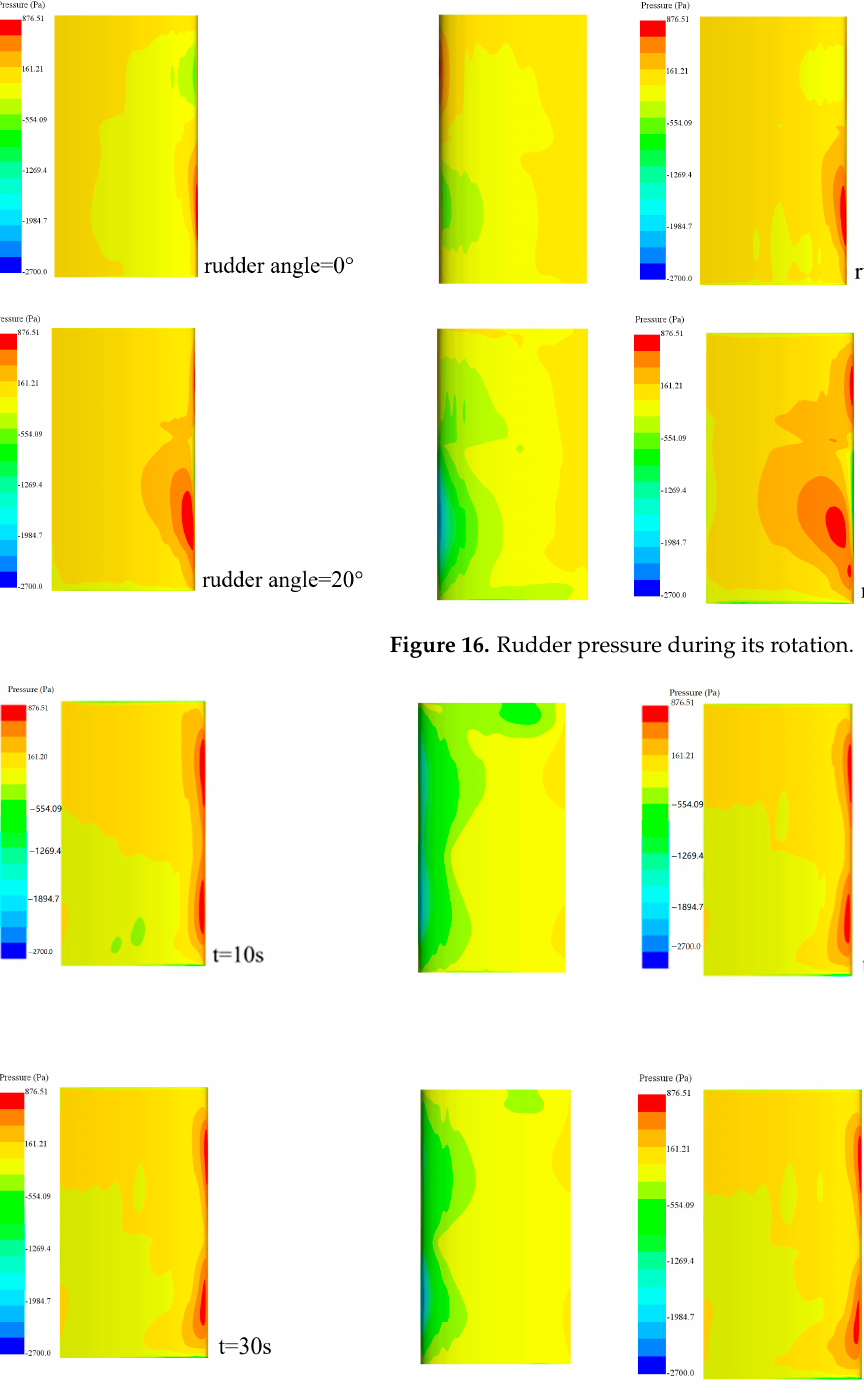
Figure 18. +35° drift angle in CFD simulation.